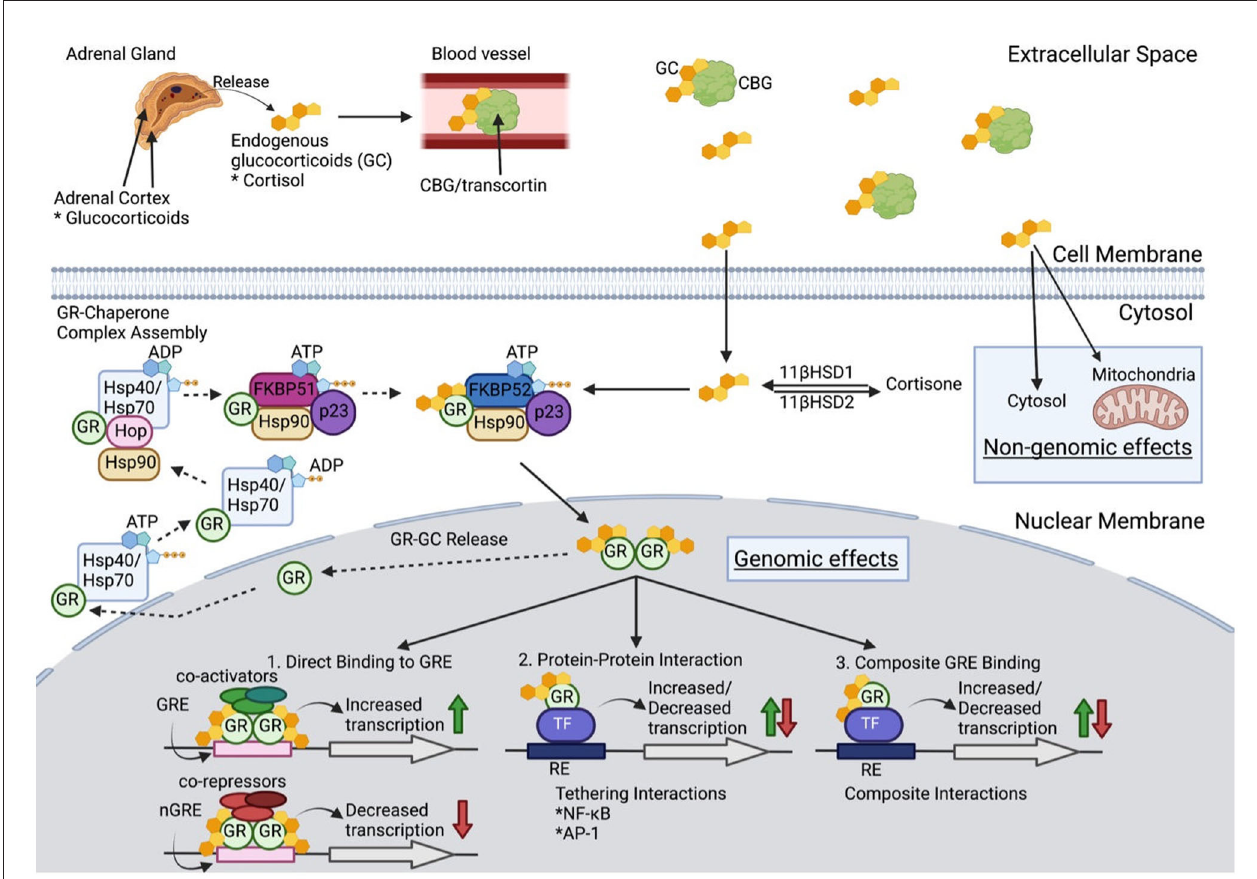
FIGURE 1 | Glucocorticoid Molecular Physiology. Once released from the adrenal cortex, glucocorticoids (GC) travel through blood with the carrier protein, corticosteroid-binding globulin (CBG). Only 5% of extracellular GCs remain bioactive after binding to CBG. GC diffuse through the cell membrane to either (1) be converted into inactive cortisone via 11 β -hydroxysteroid dehydrogenase 2, (2) have non-genomic effects in the cytosol or mitochondria, or (3) bind to the glucocorticoid receptor (GCR) as a chaperone complex to later exert genomic effects in the nucleus. When no cytoplasmic bioactive GCs are present, a multiprotein complex begins GR maturation to prepare for GC binding. Once matured, GCR’s two nuclear localizations signals are exposed, which are then bound by nucleoporin and importins that translocate cytoplasmic GC into the nuclear membrane. Inside the nucleus, the GCR complex can be released, and the GR can be transported back to the cytoplasm, or the GR-GC complex can exert its function. Genomic effects include three categories: (1) direct binding to GC response elements (GREs) or negative GREs (nGREs) which recruit transcriptional co-activators and co-repressors respectively, (2) protein-protein interaction with transcription factors (TF) that modify transcription, and (3) composite interactions that involve DNA binding to GRE to alter transcription (see text for further